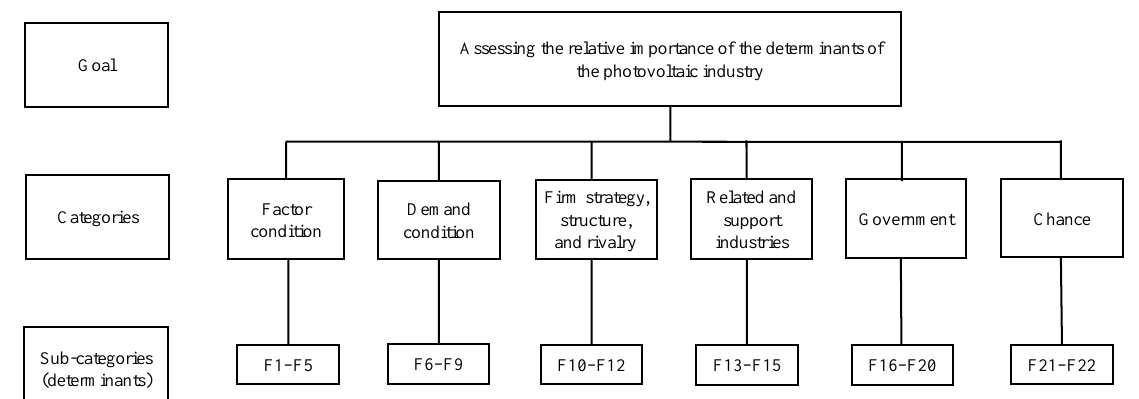
Figure 1. Hierarchical structure. See Table 5 for the definitions of F1–F22.